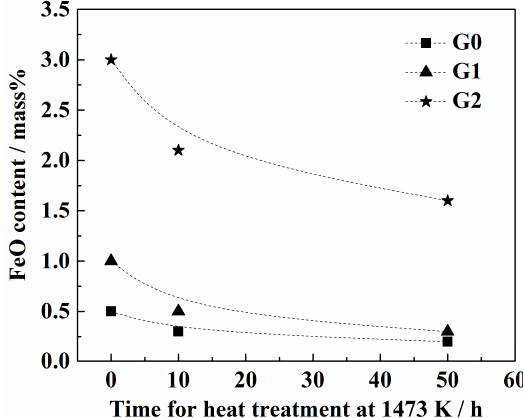
Figure 15. FeO content in the oxide near the interface varying with heat treatment time.